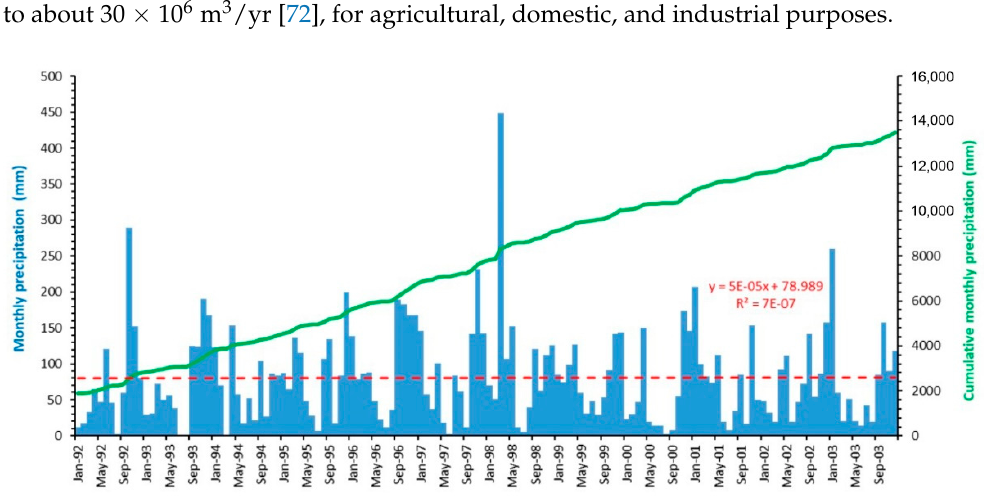
Figure 8. Monthly rainfall (mm) at Sarno rain gauge station (Figure 1B for location) in the period of 1992–2003. Dotted red line indicates the mean long-term